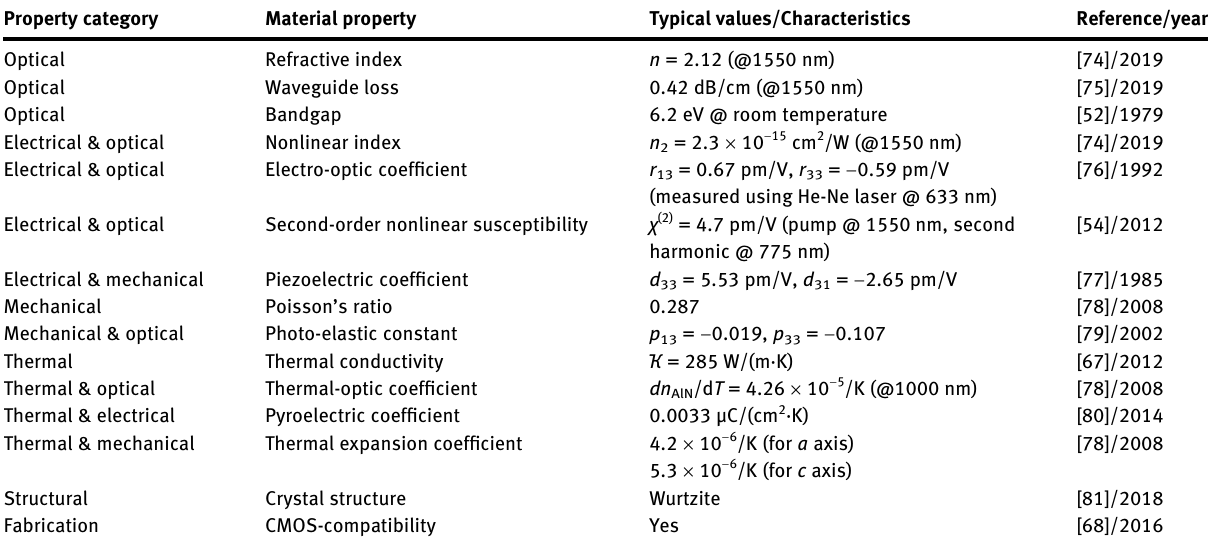
Table  : Material property of AlN for integrated photonics. Property